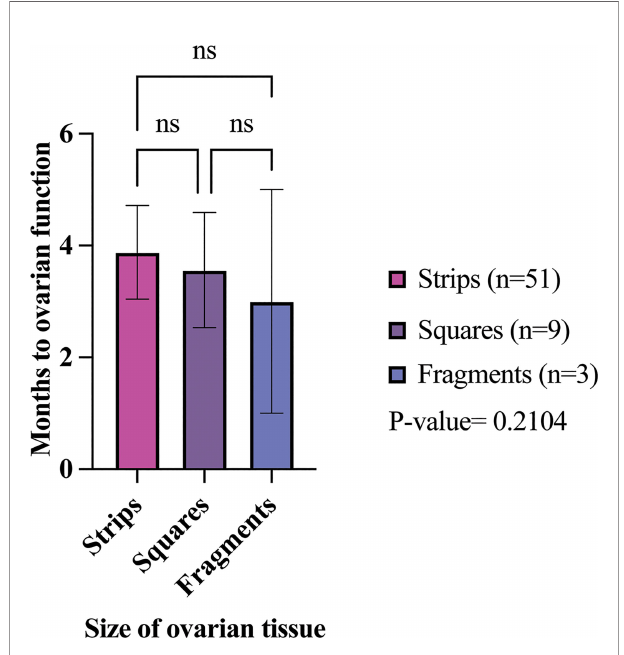
FIGURE 5 | Months to restoration of ovarian activity in different size transplanted ovarian tissues. The average time to ovarian restoration per fi rst OTT was 3.88, 3.56, and 3 months in the strip, square, and fragment groups, respectively. P-values greater than 0.05 were considered not signi fi cantly different (ns) (21, 22, 25, 34, 37, 44, 57, 59, 61, 64, 66, 78, 84, 91 – 93, 95, 111, 115, 118,